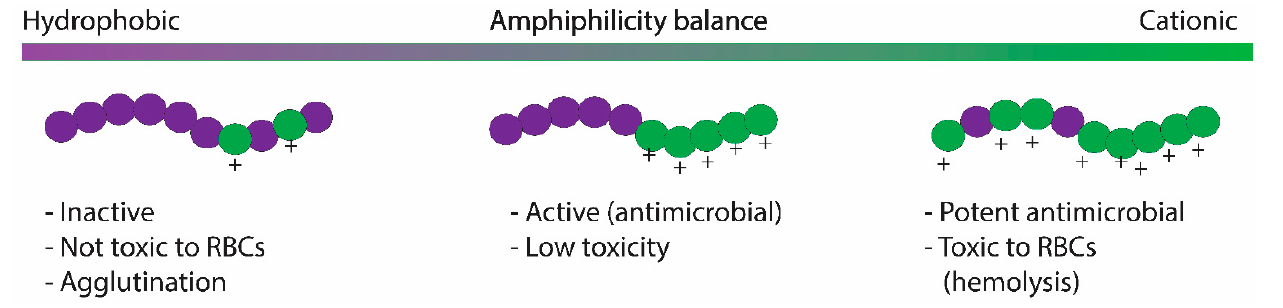
Figure 3. The diagram shows the influence of cationic/hydrophobic balance in the biological activity and toxicity of HDP-mimicking polymers.